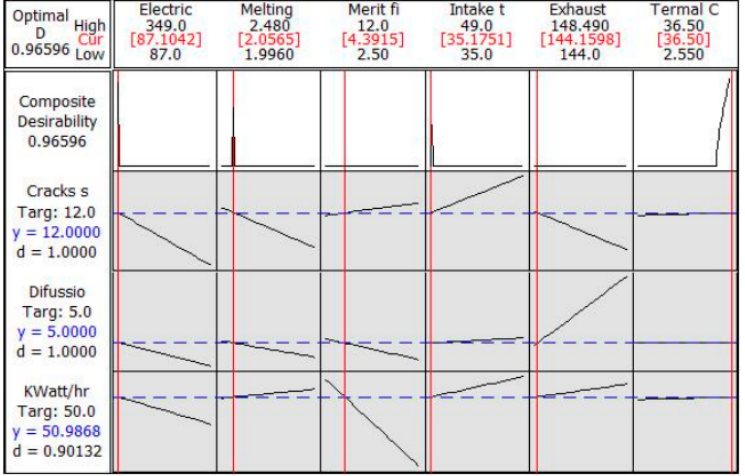
Figure 12. The significant parameters affected by the thermal conductor’s quick failure on the gasket